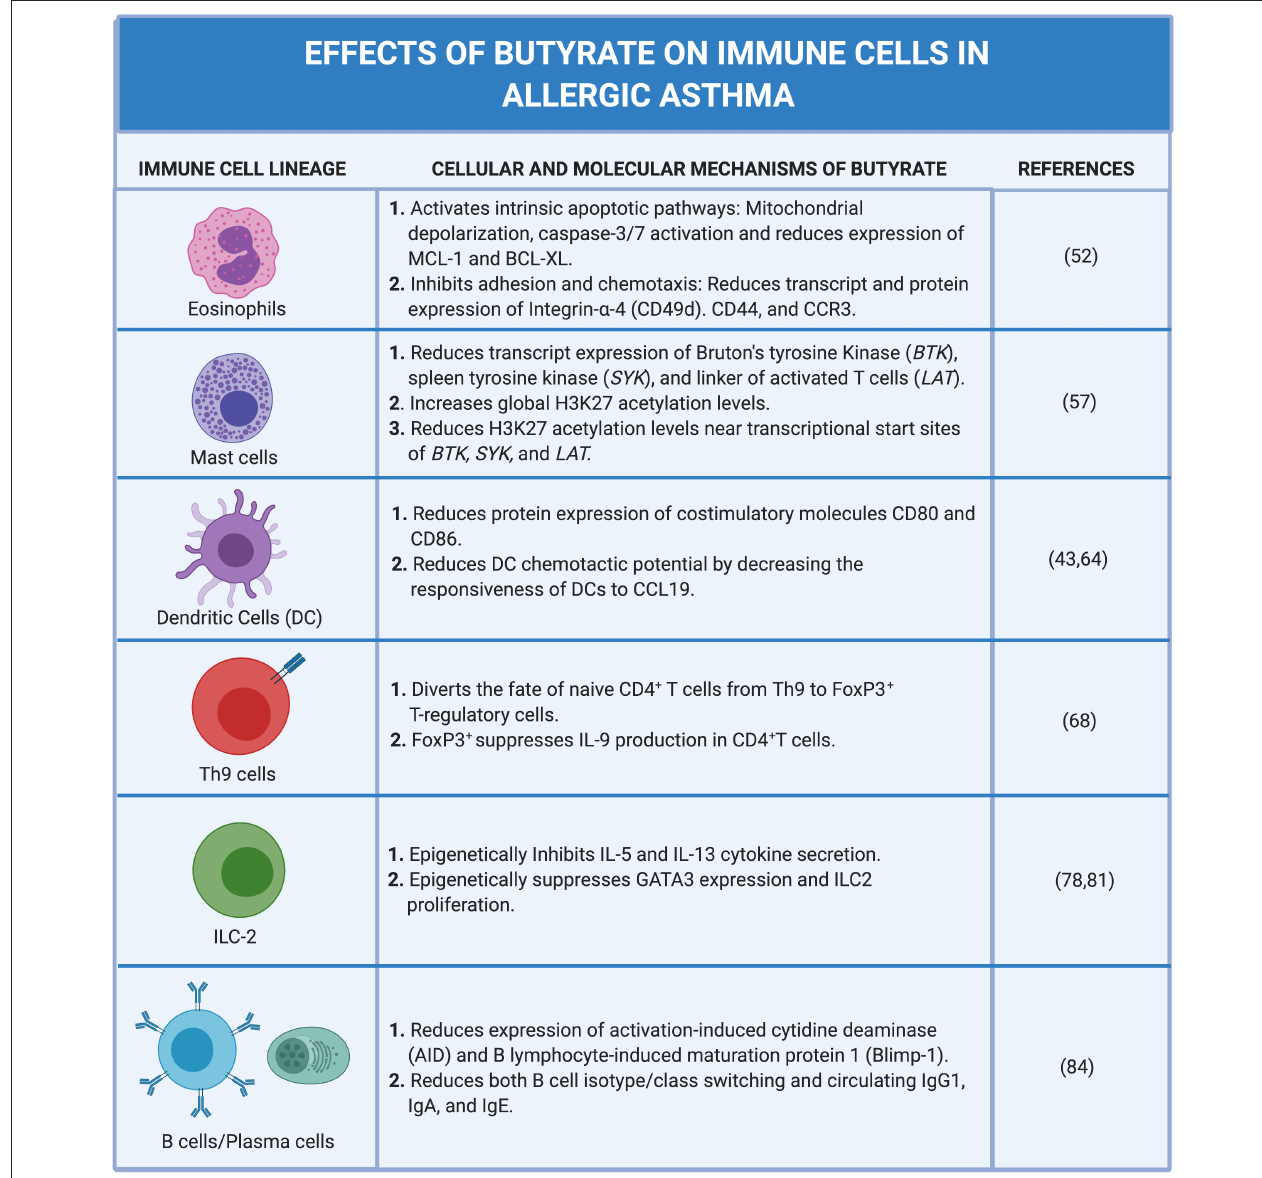
FIGURE 4 | Cellular and molecular mechanisms of butyrate on immune cells in allergic asthma. Created with https://biorender.com/.